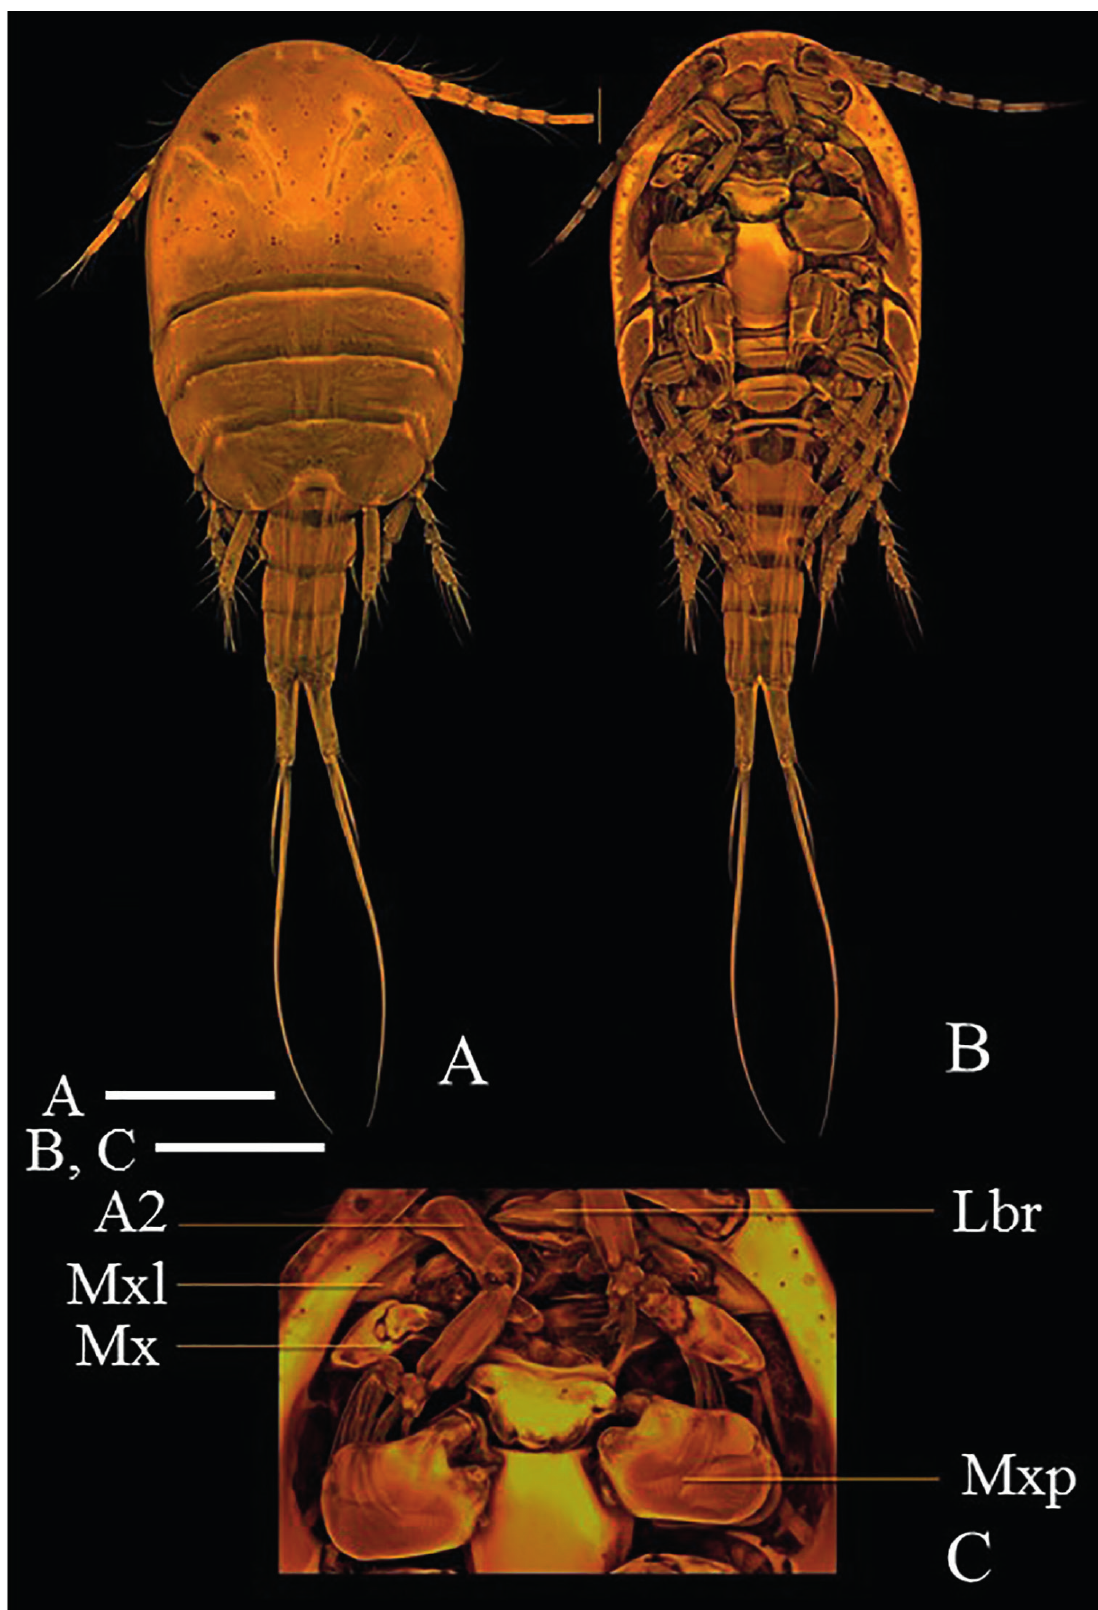
Figure 10. Clausidium persiaensis sp. nov. (male) Confocal laser scanning microscopy images. A, habitus, dorsal; B, habitus, ventral; C, oral region. Scale bars: A, B, 100 μm; C, 50